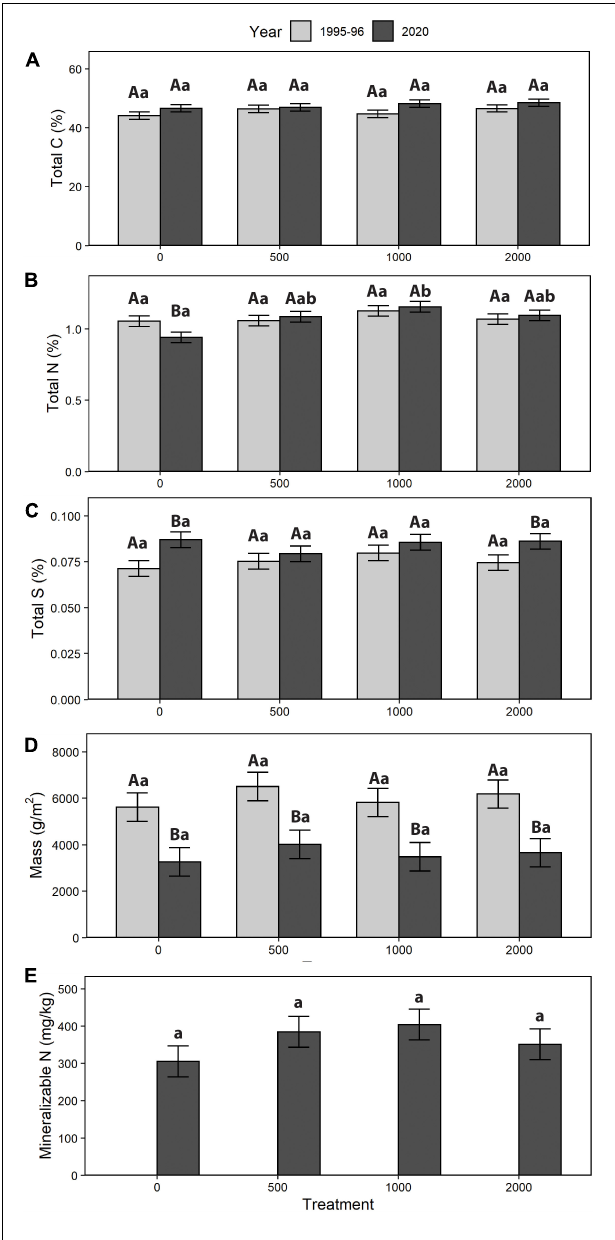
FIGURE 4 | Forest floor change (1995/1996–2020): (A) total carbon (C), (B) total nitrogen (N), (C) total sulphur (S), (D) mass, and (E) mineralizable N (treatment means). Different letters indicate significant differences between years (A, B) or treatment within a year (a, b; p < 0.05). For mineralizable N, comparable data were not available for 1995/1996, so only treatment differences in 2020 were analyzed ( F = 1.10, p = 0.4031, df = 3,